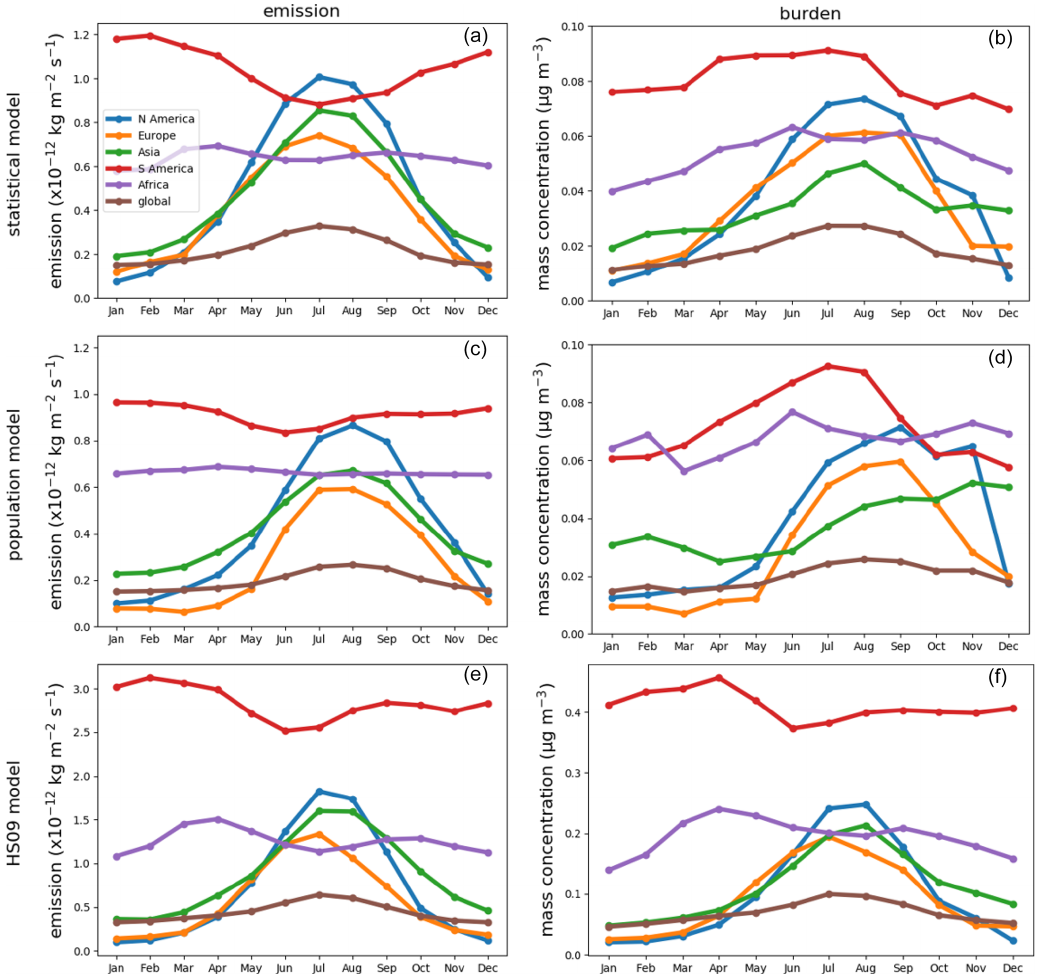
Figure 7. Seasonal cycles of fungal spore emissions (a, c, e) and concentrations (b, d, f) for the statistical, the population and the HS09 model. Note the different scales on the y